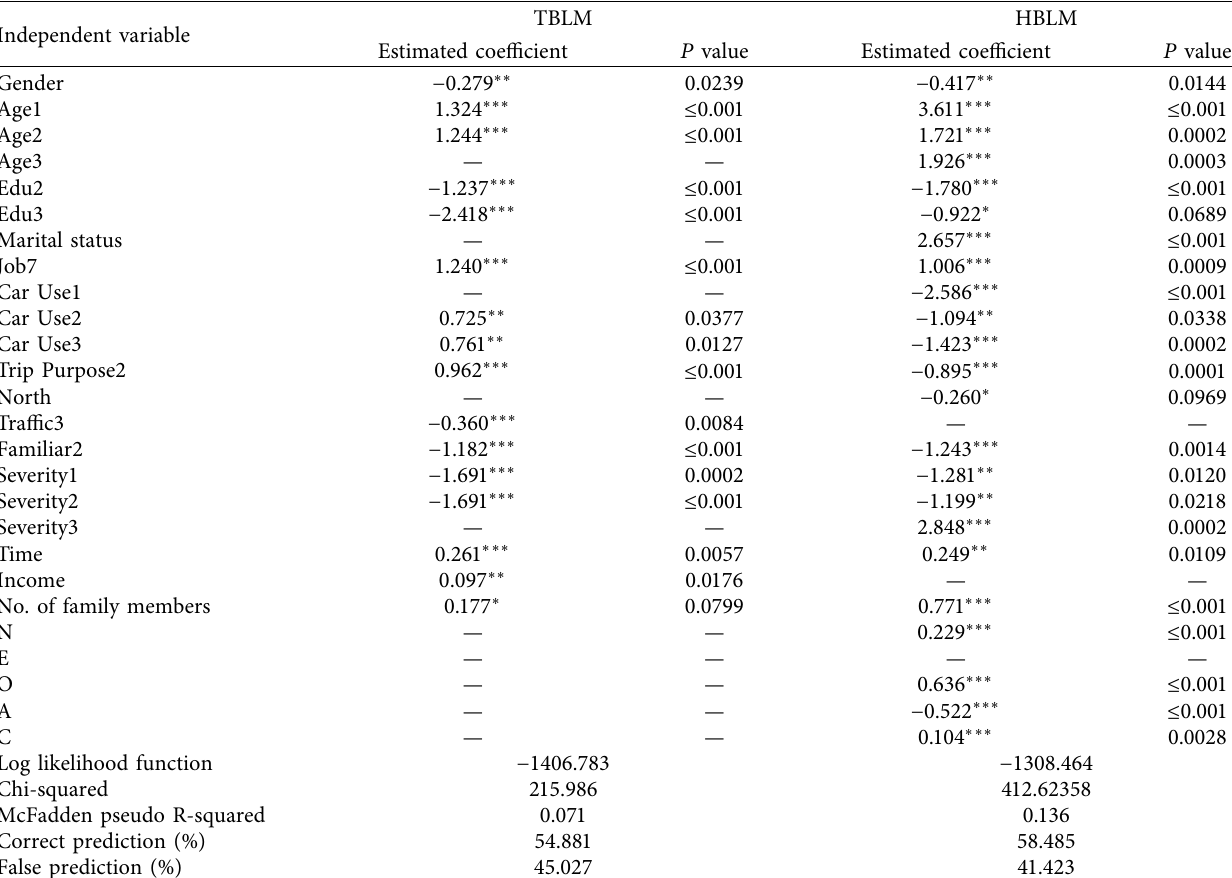
Table 7: The results of TBLM and